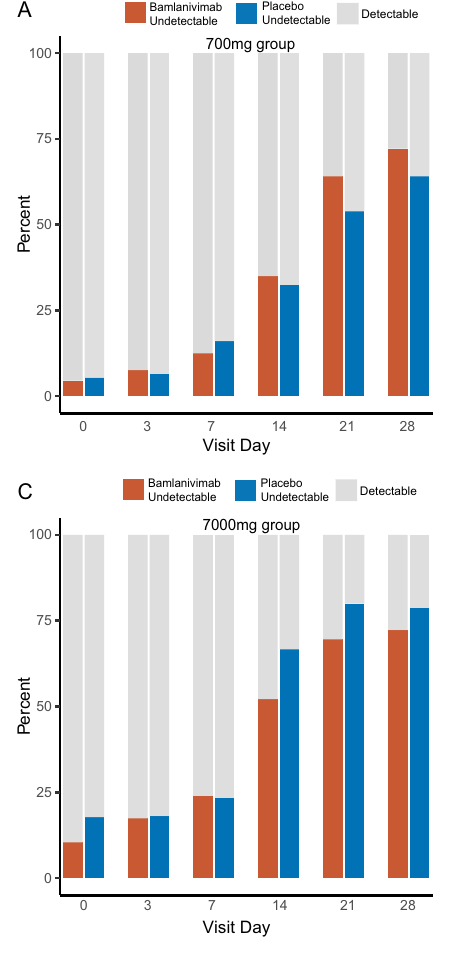
Fig. 2 | Nasopharyngeal (NP) SARS-CoV-2 RNA levels (viral loads) by dose cohort, treatment arm, and visit. NP viral loads declined in all participants, without a difference in proportion undetectable at any time points (primary vir- ologicoutcome)foreitherthe700mgbamlanivimabdose( A )orthe7000mgdose ( C ), with risk ratio (RR) [95% con fi dence interval, CI] for non-detection of SARS- CoV-2RNAforbamlanivimabvsplacebointhe700mgdosecohort(bamlanivimab n =111,placebo=112)of1.21(0.48,3.06)atday3and0.81(0.43,1.53)atday7,orthe 7000mg dose cohort(bamlanivimab n =48, placebo=46), 0.97 (0.44, 2.16) atday 3 and 1.05 (0.53, 2.08) at day7 (see Table 3 for risk ratios atlatertime points).Risk ratios and 95% CI were calculated by Poisson regression model for repeated mea- sures with robust variance and log-link fi t with generalized estimating equations